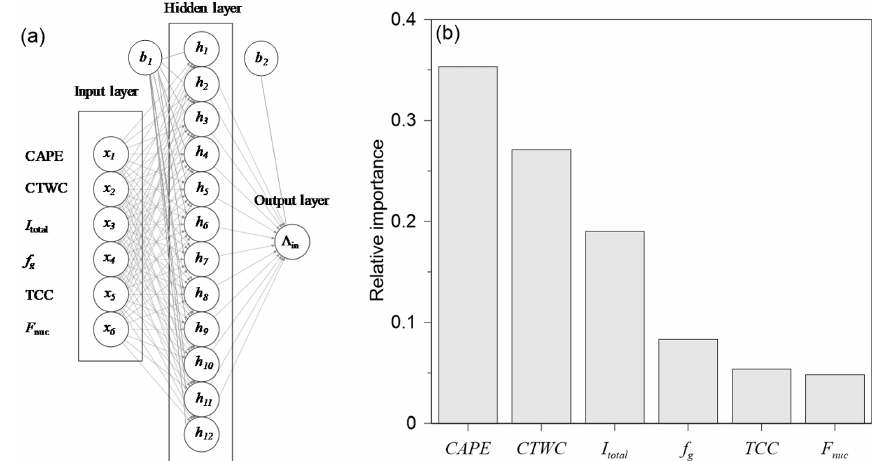
Figure 7. (a) Schematic of an artificial neuron network (ANN) model with 12 nodes of a single hidden layer. (b) The relative importance of six meteorological input variables used for calculating in-cloud scavenging coefficients in the FLEXPART model (except for CAPE), using Garson’s algorithm implemented in the “NeuralNetTools” package in R. CAPE, CTWC, I total , f g , TCC, and F nuc represent the convective available potential energy, specific cloud total water content, precipitation rate, fraction of a subgrid in a grid cell (see text for details), total cloud cover, and nucleation efficiency,